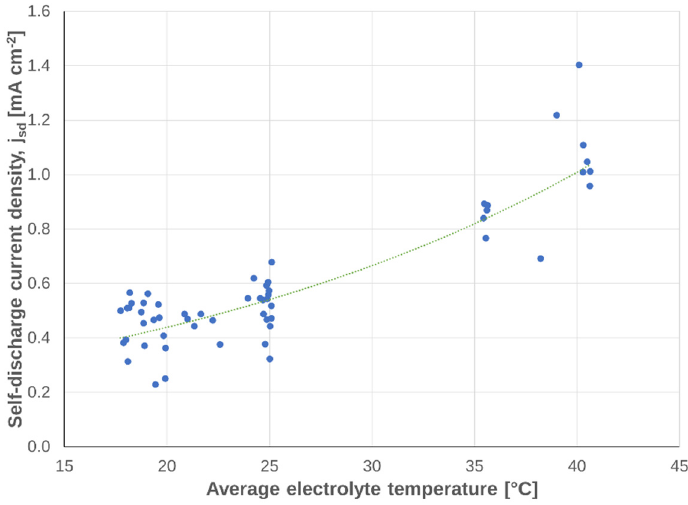
Figure 5. Self-discharge current density of a vanadium redox flow cell under constant current cycling conditions of 100 mA cm − 2 over a range of electrolyte temperatures. Each point represents the calculated j sd of a single cycle. The regression line is intended as a guide to the eye only.